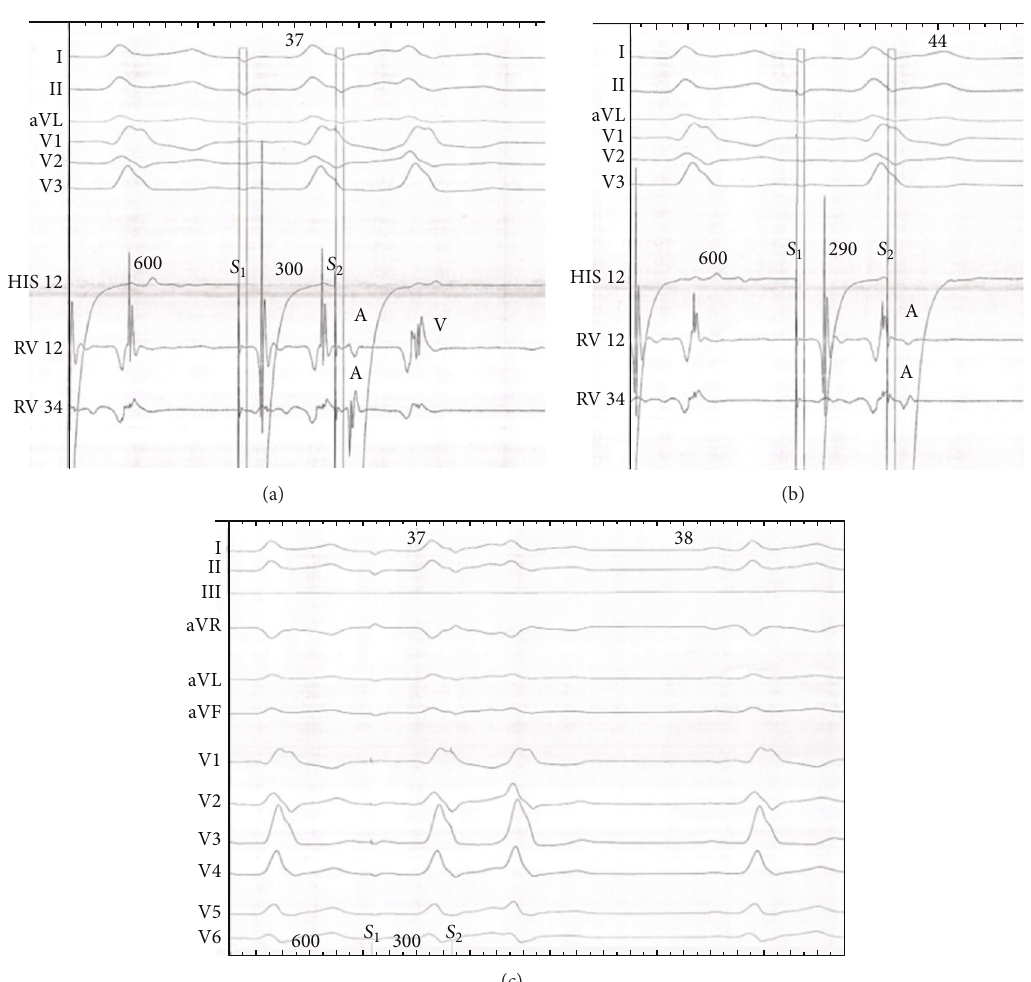
Figure 2: In atrial pacing, effective accessory pathway refractory period was 290 ms effective ((a) and (b)). The QRS had the same morphology during atrial pacing